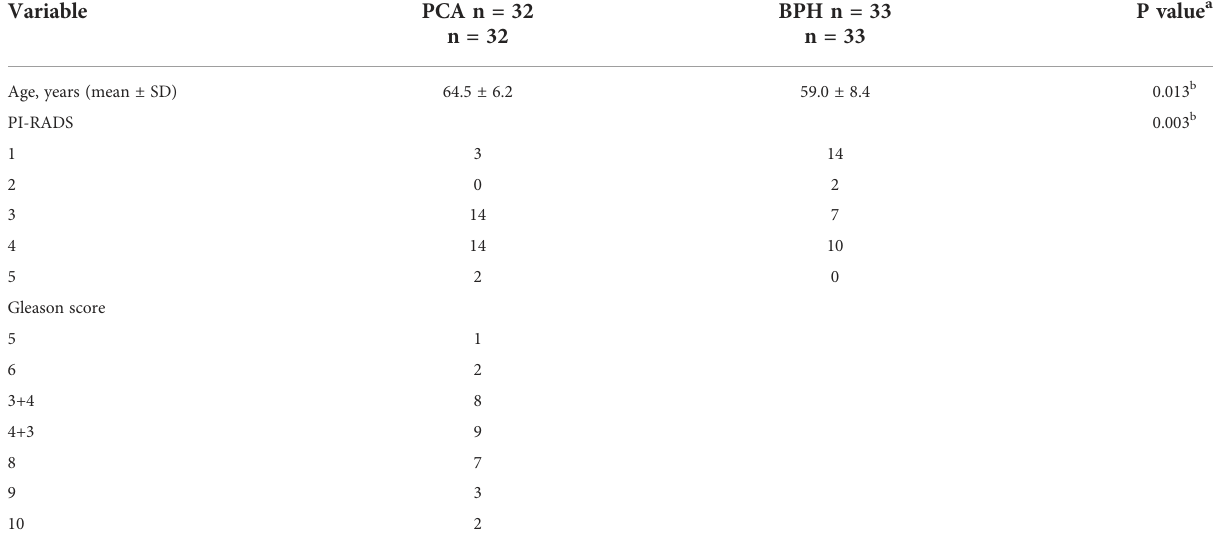
TABLE 1 Patients ’ demographic information.